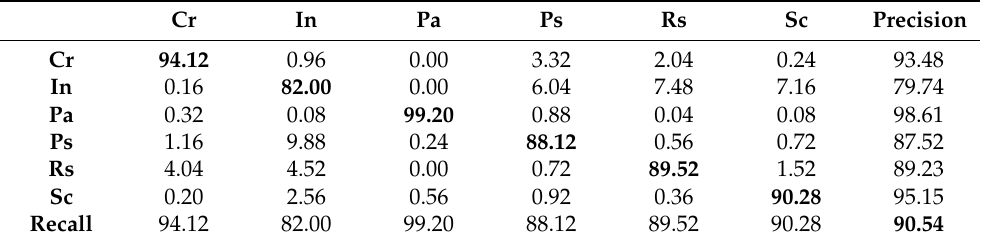
Table 8. The confusion matrices when adopting the MRFFN+IA method on density 0.3 task containing six types of defects (%), where Cr, In, Pa, PS, RS, and Sc denote the crazing, inclusion, patches, pitted surface, rolled-in scale, and scratches defects